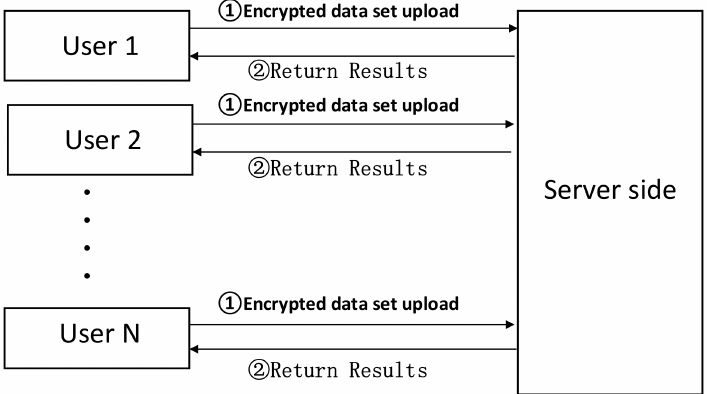
Figure 1. Privacy-preserving model for outsourced computing based on homomorphic